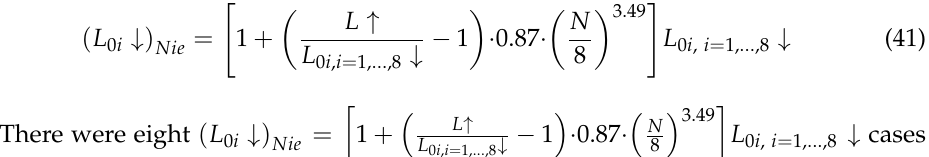
Table 13. Statistical errors for all sky conditions. Each error is represented in three separated columns for Jacobs [49], Maykut and Church [50] cloudiness and for Niemelä et al. [43] parameterization. Shown errors are calculated in 2 · 8 + 8 = 24 cases. In the last two rows, we show Holtslag and Van Ulden [5] cloudiness corrections with Swinbank [47] ( L 05 ↓ ) with Dilley and O’Brien [48] ( L 06 ) parameterizations (gray belt, best solution). HVU LW